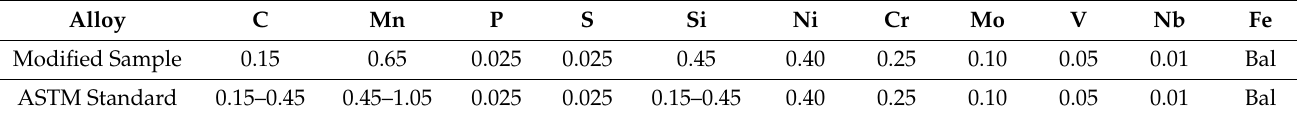
Table 2. Modified chemical compositions in SA508 Gr 1 (wt.%) along with the ASTM standard [11]. Alloy C Modified Sample